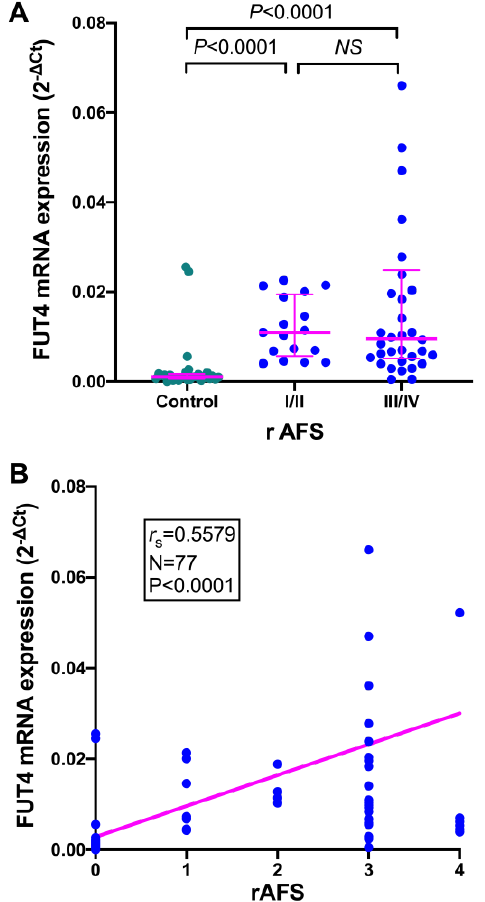
Figure 2. Expression of FUT4 mRNA in the endometrium relative to the stage of endometriosis. ( A ) Expression of FUT4 mRNA in the endometrium from patients with minimal/mild (I/II) ( n = 14) and moderate/severe (III/IV) ( n = 35) stages of endometriosis compared to the endometrium from control women ( n = 28). Data are shown as scatterplots with the median and interquartile range. Statistical differences between groups were computed by the Kruskal–Wallis test and Dunn’s post hoc test. ( B ) Correlation between FUT4 mRNA and the rAFS score of the disease. The results are shown as scatterplots with a regression line. Samples from the endometriosis group displaying relative expression values over 0.08 ( n = 3) are not included in the graph. Spearman’s correlation coefficients (r s ), their p -values and the number of cases ( n ) are shown in an inset. Localization of endometriotic lesions (ovarian, peritoneal or both) had no impact on the expression of FUT4 mRNA in the endometrium of women with endometriosis. Irrespective of localization in all cases, the FUT4 mRNA levels were significantly higher compared to the endometrium samples from the control group (Figure